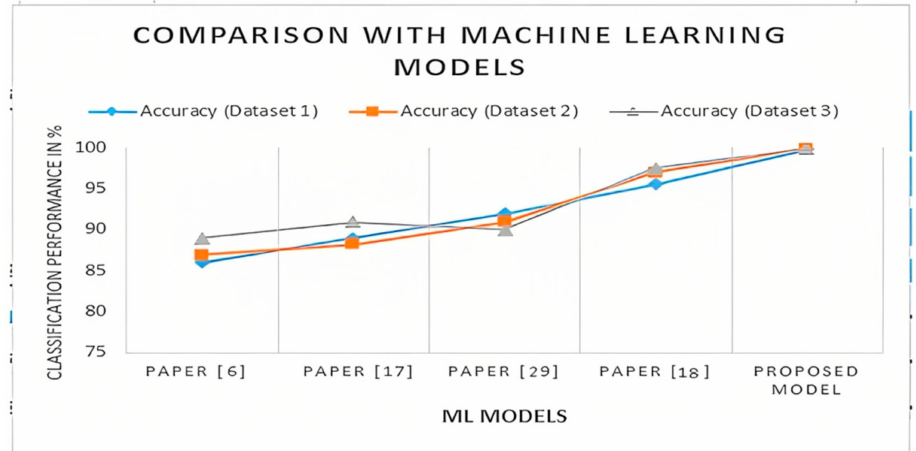
Figure 12. Performance comparison with machine learning